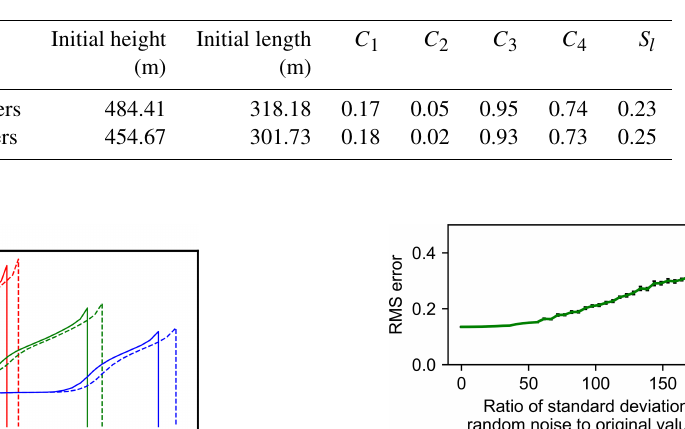
Table 2. The predicted and true parameters used for an example calculation of the time evolution of the flow characteristics.